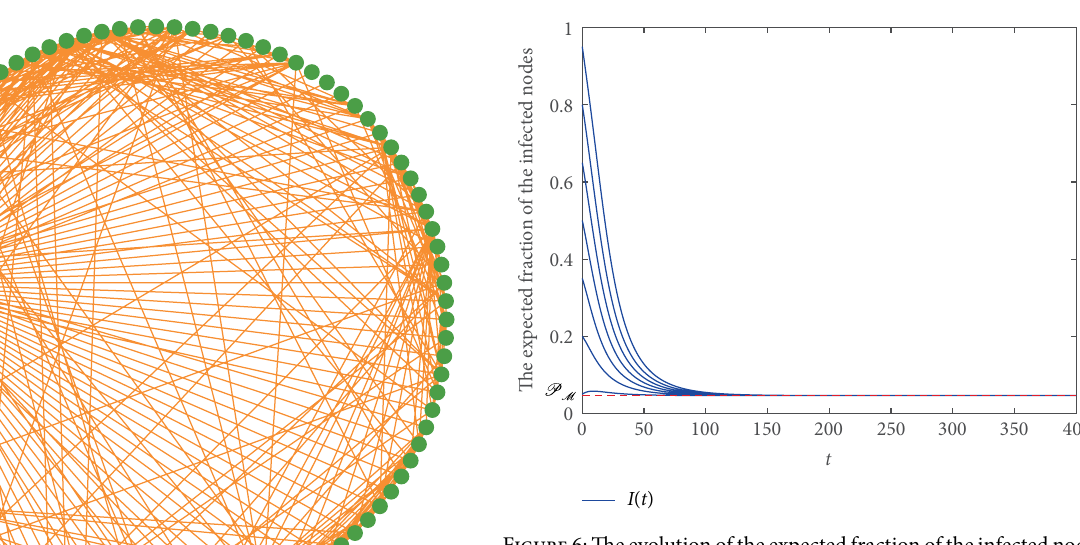
Figure 6: The evolution of the expected fraction of the infected nodes in Example 2.